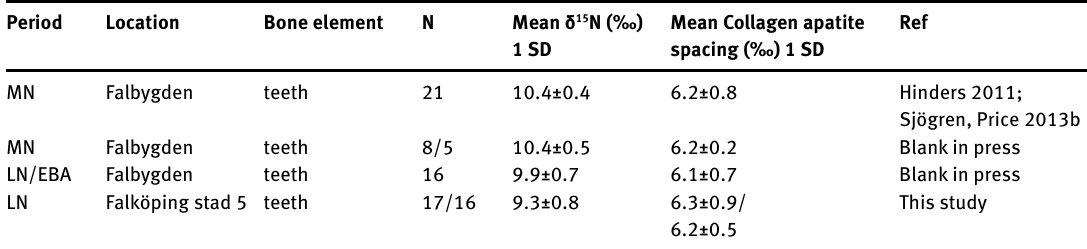
Table 5. Summary statistics of light stable isotopes from megalithic populations in Falbygden. MN: Middle Neolithic, LN: Late Neolithic, EBA: Early Bronze